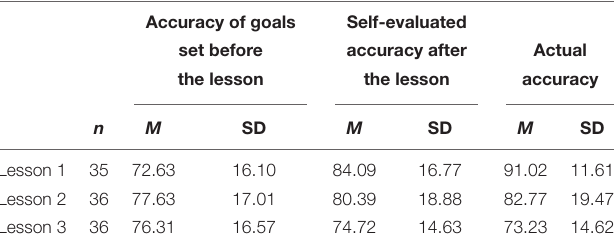
TABLE 7 | Overview of the intentions of learners for regulation : accuracy of goals, self-evaluated accuracy, and actual accuracy per lesson. Accuracy of